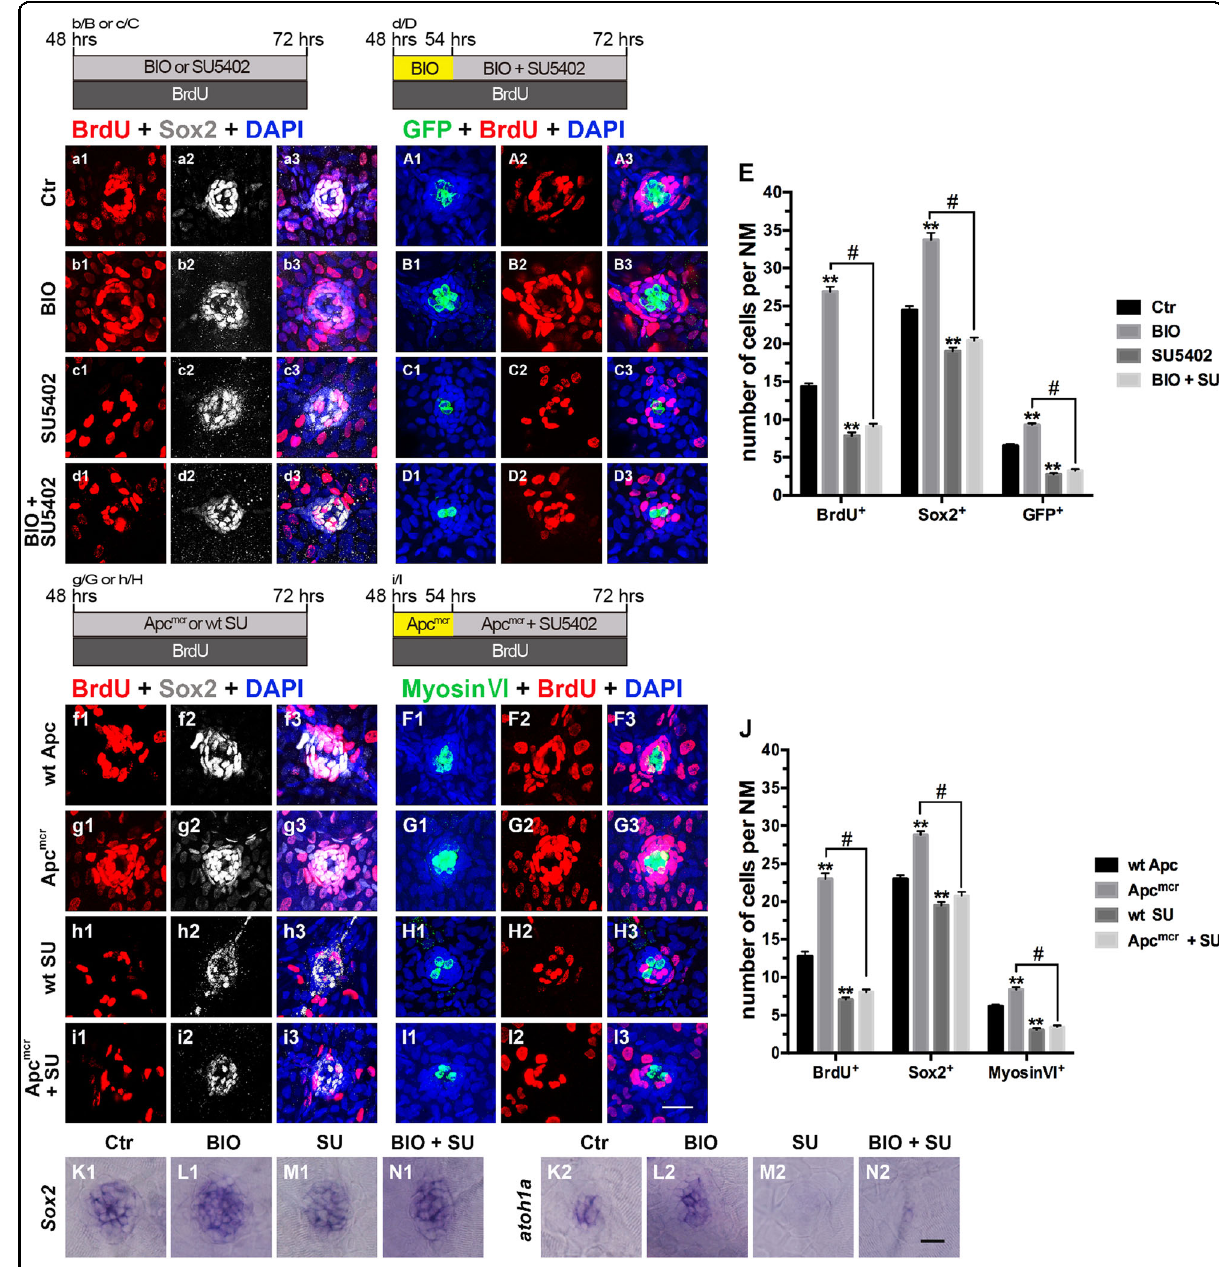
Fig. 2 Effects of the Wnt and FGF signaling pathways on proliferation and differentiation during initial neuromast development. a1 – D3 : Proliferative cells labeled with BrdU (red), SCs labeled with Sox2 (white), and HCs labeled with GFP (green). a1 – A3 : Control neuromast; b1 – B 3: After addition of BIO; c1 – C3 : After addition of SU5402; d1 – D3 : After 6 h of incubation with BIO, SU5402 and BIO were added for 18 h; e : Quanti fi cation of the proliferative cells (BrdU + ), SCs (Sox2 + ), and HCs (GFP + ) shown in a1 – D3 . f1 – I3 : Proliferative cells labeled with BrdU (red), SCs labeled with Sox2 (white), and HCs labeled with myosin VI (green). f1 – F3 : wt Apc larvae; g1 – G3 : Apc mcr mutants; h1 – H3 : After addition of SU5402; i1 – I3 : 54 hpf Apc mcr embryos were treated with SU5402 for 18 h. j : Quanti fi cation of the proliferative cells (BrdU + ), SCs (Sox2 + ), and HCs (Myosin VI + ) shown in f1 – I3 . n = 5 – 7 fi sh per group. ** Indicates p < 0.001, # indicates p < 0.05, and error bars indicate the standard error of the mean. K1 – N1 and K2 – N2 : WISH analysis of Sox 2 ( K1 – N1 ) and atoh1a ( K2 – N2 ) expression in the neuromasts from different groups. Scale bar in I3 = 20 μ m for a1 – D3 and f1 – I3 . Scale bar in N2 = 30 μ m for K1 – N1 , K2 –